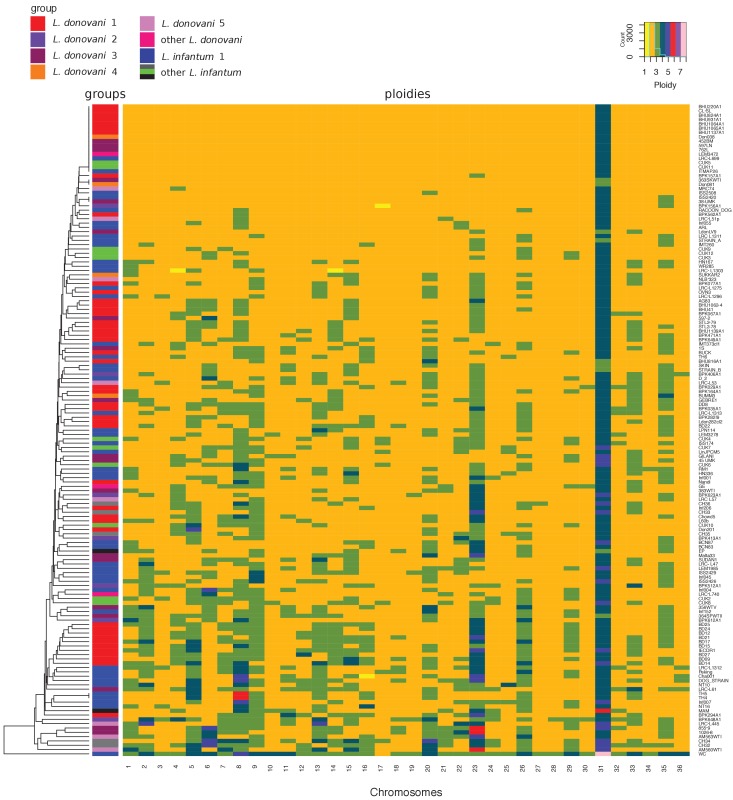
Aneuploidy patterns across all 151 samples.The heatmap displays the ploidies of the individual chromosomes and samples. Samples, displayed in different rows, are ordered by average linkage clustering and chromosomes are shown in different columns. Different ploidies are indicated by the colours in the heatmap (legend: upper right corner). The column on the left indicates the different phylogenetic groups (legend: upper left corner).